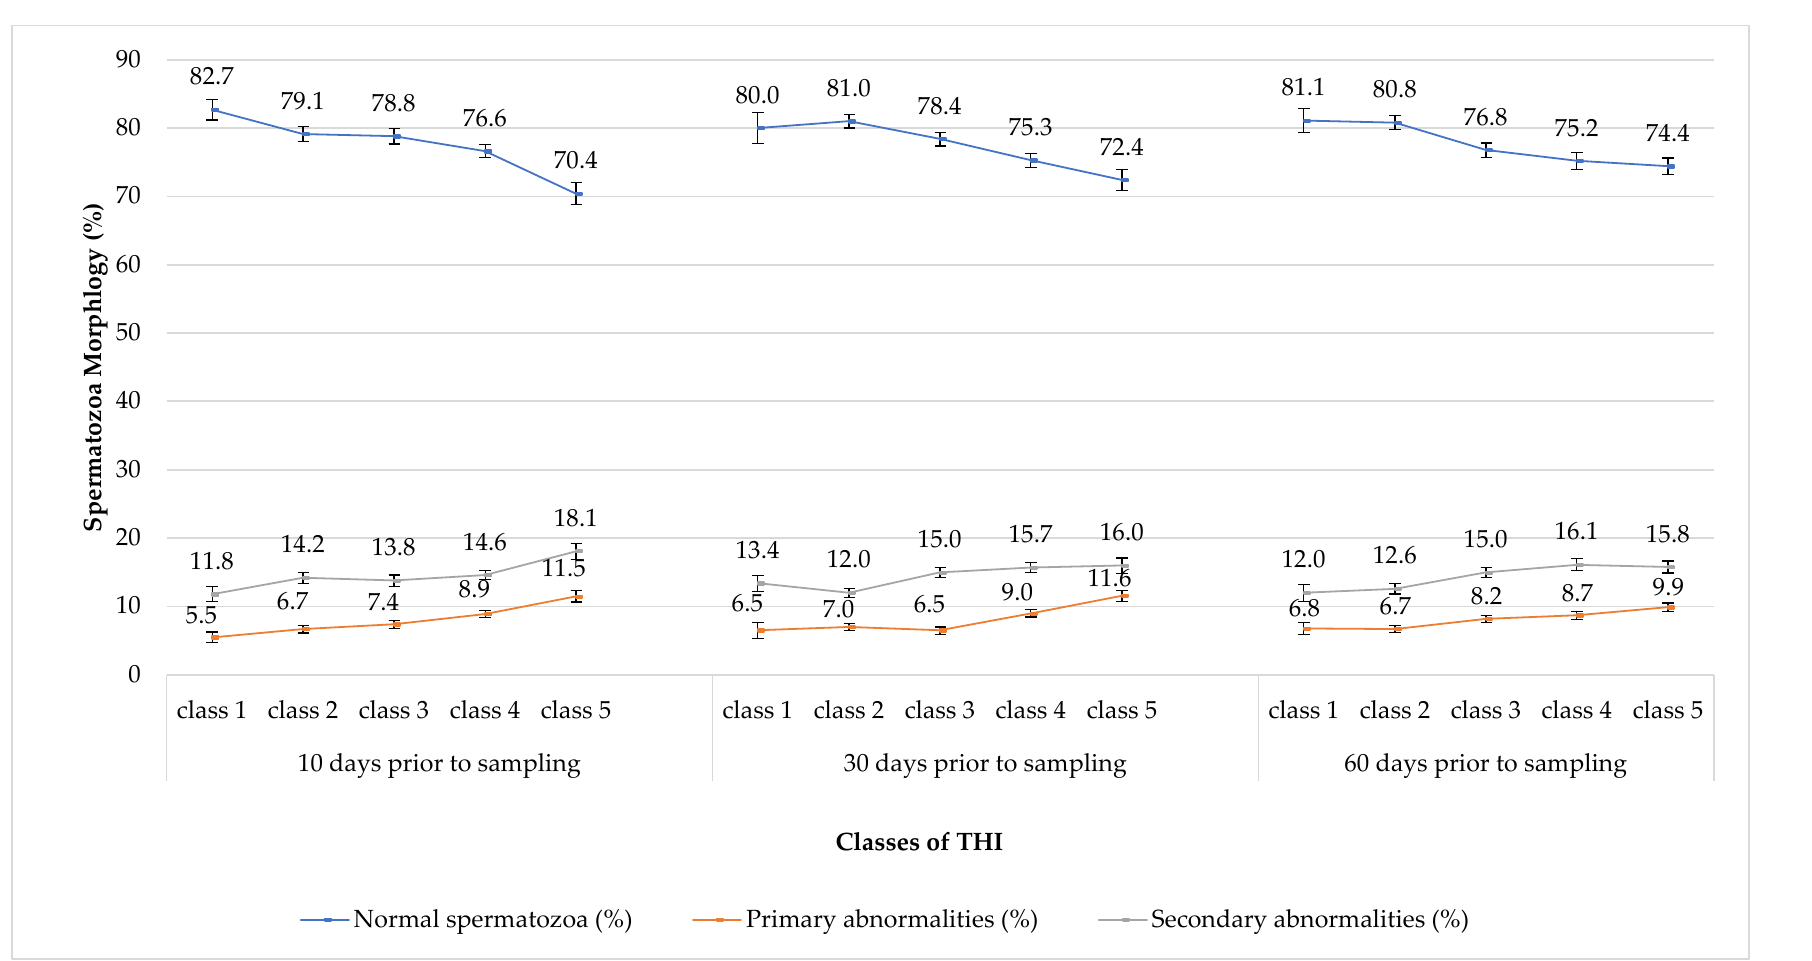
Figure 4. Trends of spermatozoa morphology (normal and abnormal sperm cells) corrected means through the five increasing classes of THI for the three periods of spermatogenesis considered.